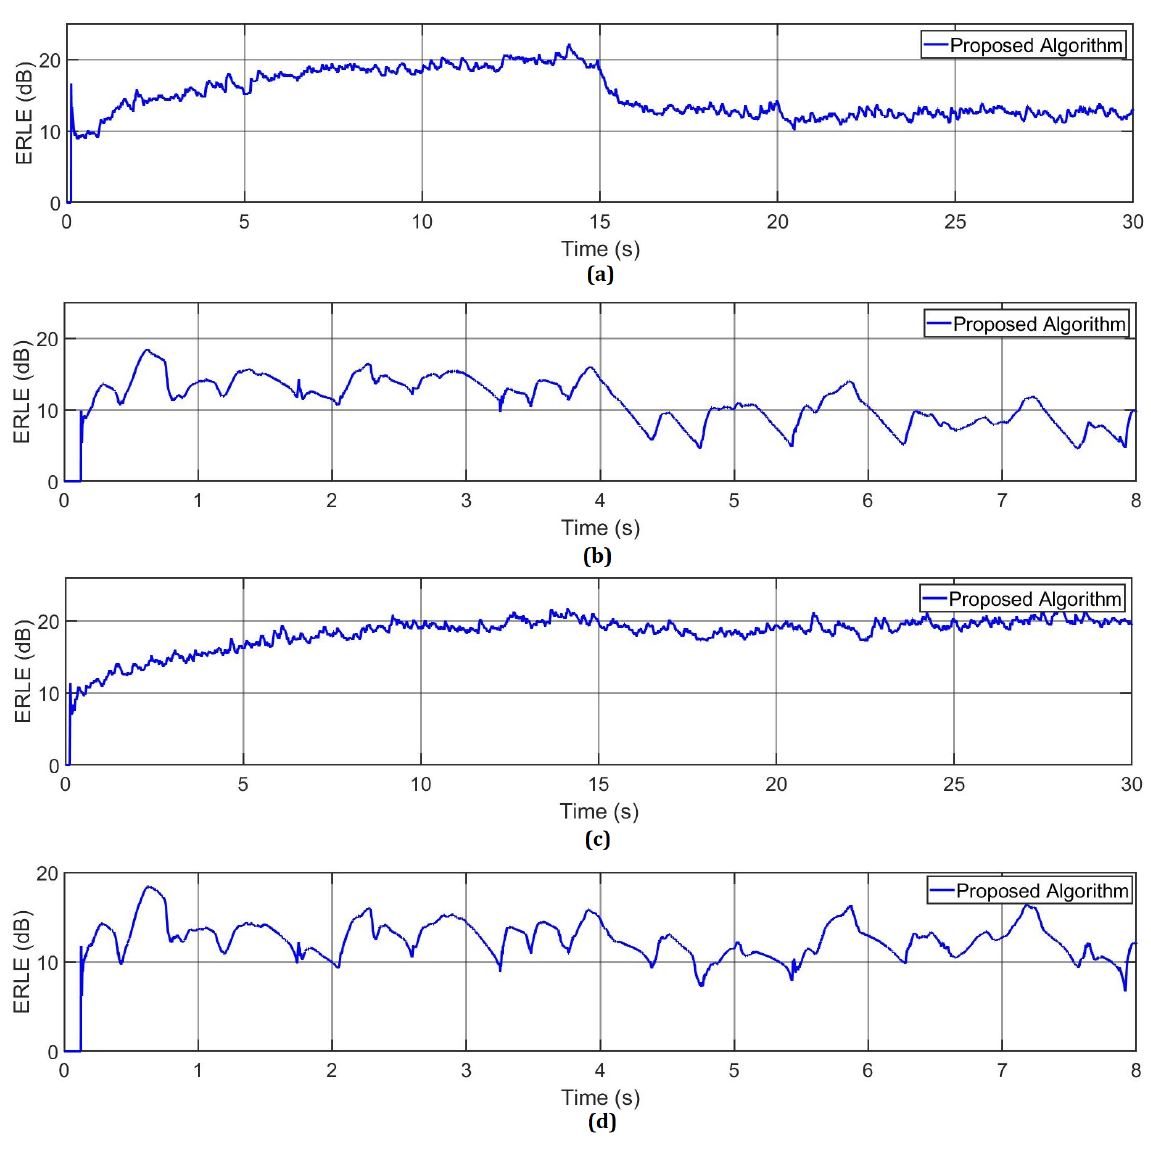
Figure 11. ( a ) AR(1) process and ( b ) speech signal used in a single-talk scenario; ( c ) AR(1) process and ( d ) speech signal used in a double-talk